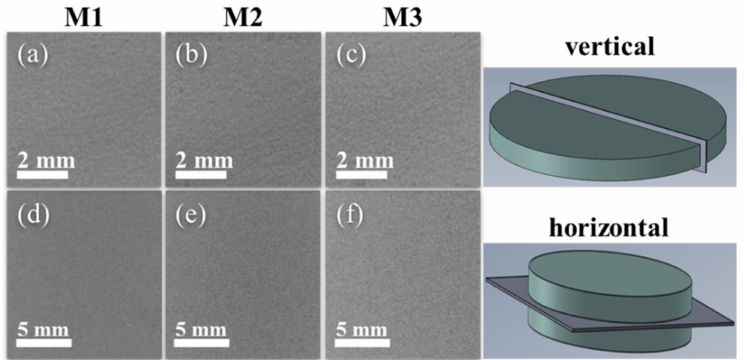
Figure 5. X-ray tomographies of ( a – c ) vertical slices to obtain a side view, and ( d – f ) horizontal slices to obtain a top view of the sintered nanocomposites. Both set of tomographies were taken in an area close to the center and show homogenous consolidation without the presence of large-sized pores. Table 2. Electrical conductivity and electrical resistivity values measured from three different zones of each sintered Al-based nanocomposite, as well as their corresponding IACS values.